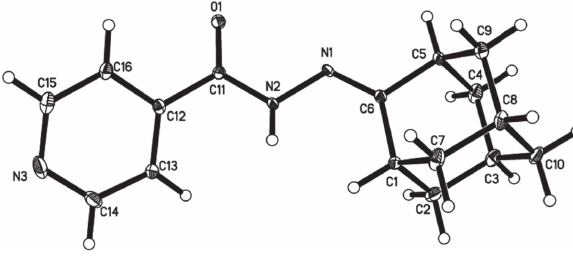
Table 1: Data collection and handling.